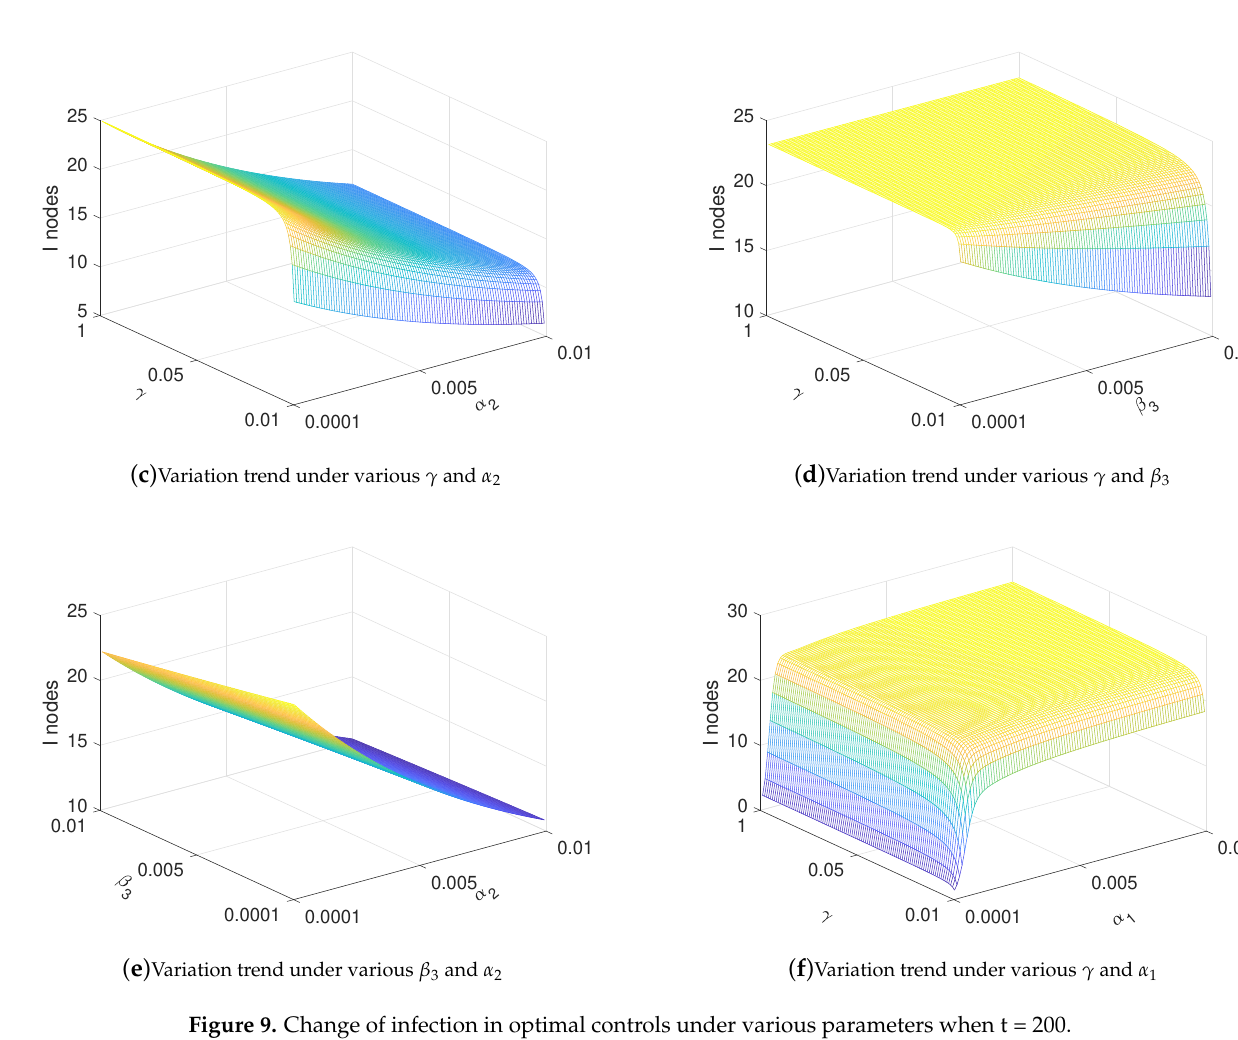
Figure 9. Change of infection in optimal controls under various parameters when t =